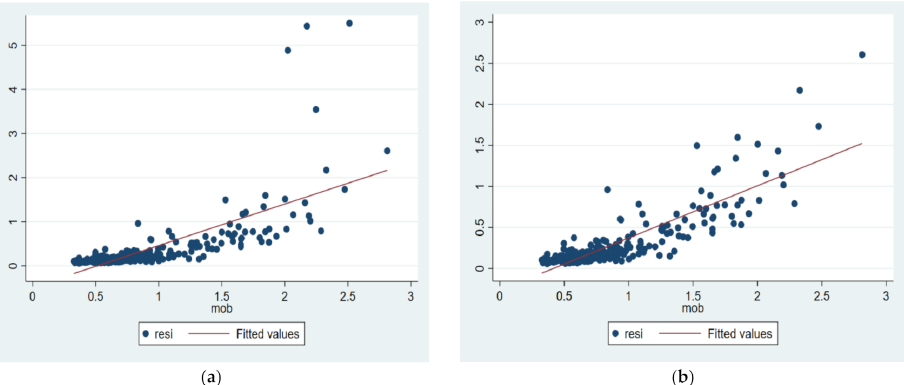
Figure 2. The relationship curve between economic resilience and population mobility. ( a ) Keep extremum, ( b ) Delete